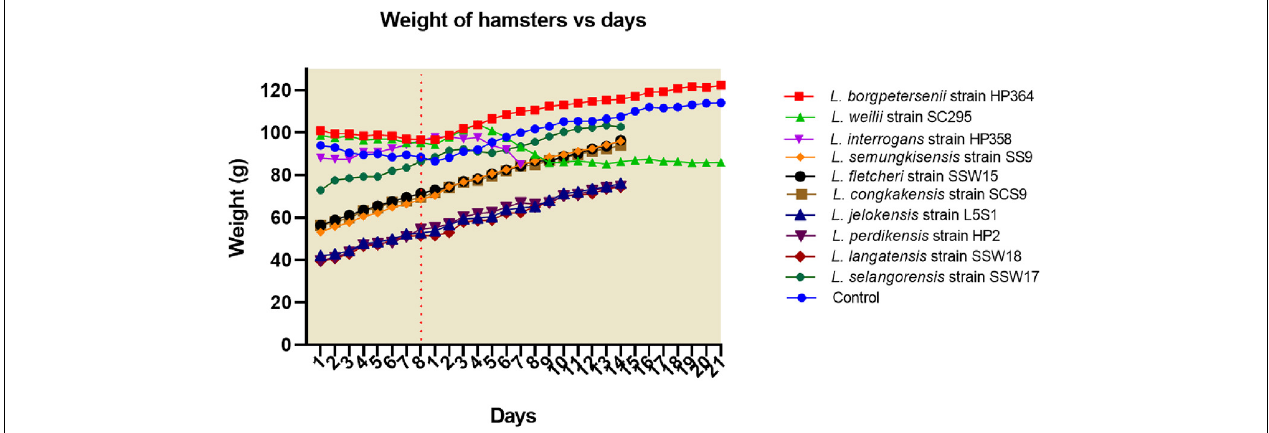
FIGURE 1 | Weight of hamsters. Only hamsters infected with L. weilii strain SC295 and L. interrogans strain HP358 showed weight loss after infections. The dot line (day 8) represents the day in which the hamsters were infected with leptospires. Days 1–8 and 1–21 were the acclimatization and postinfection periods, respectively. TABLE 2 | Clinical manifestations and survival of hamsters infected with Leptospira isolates.